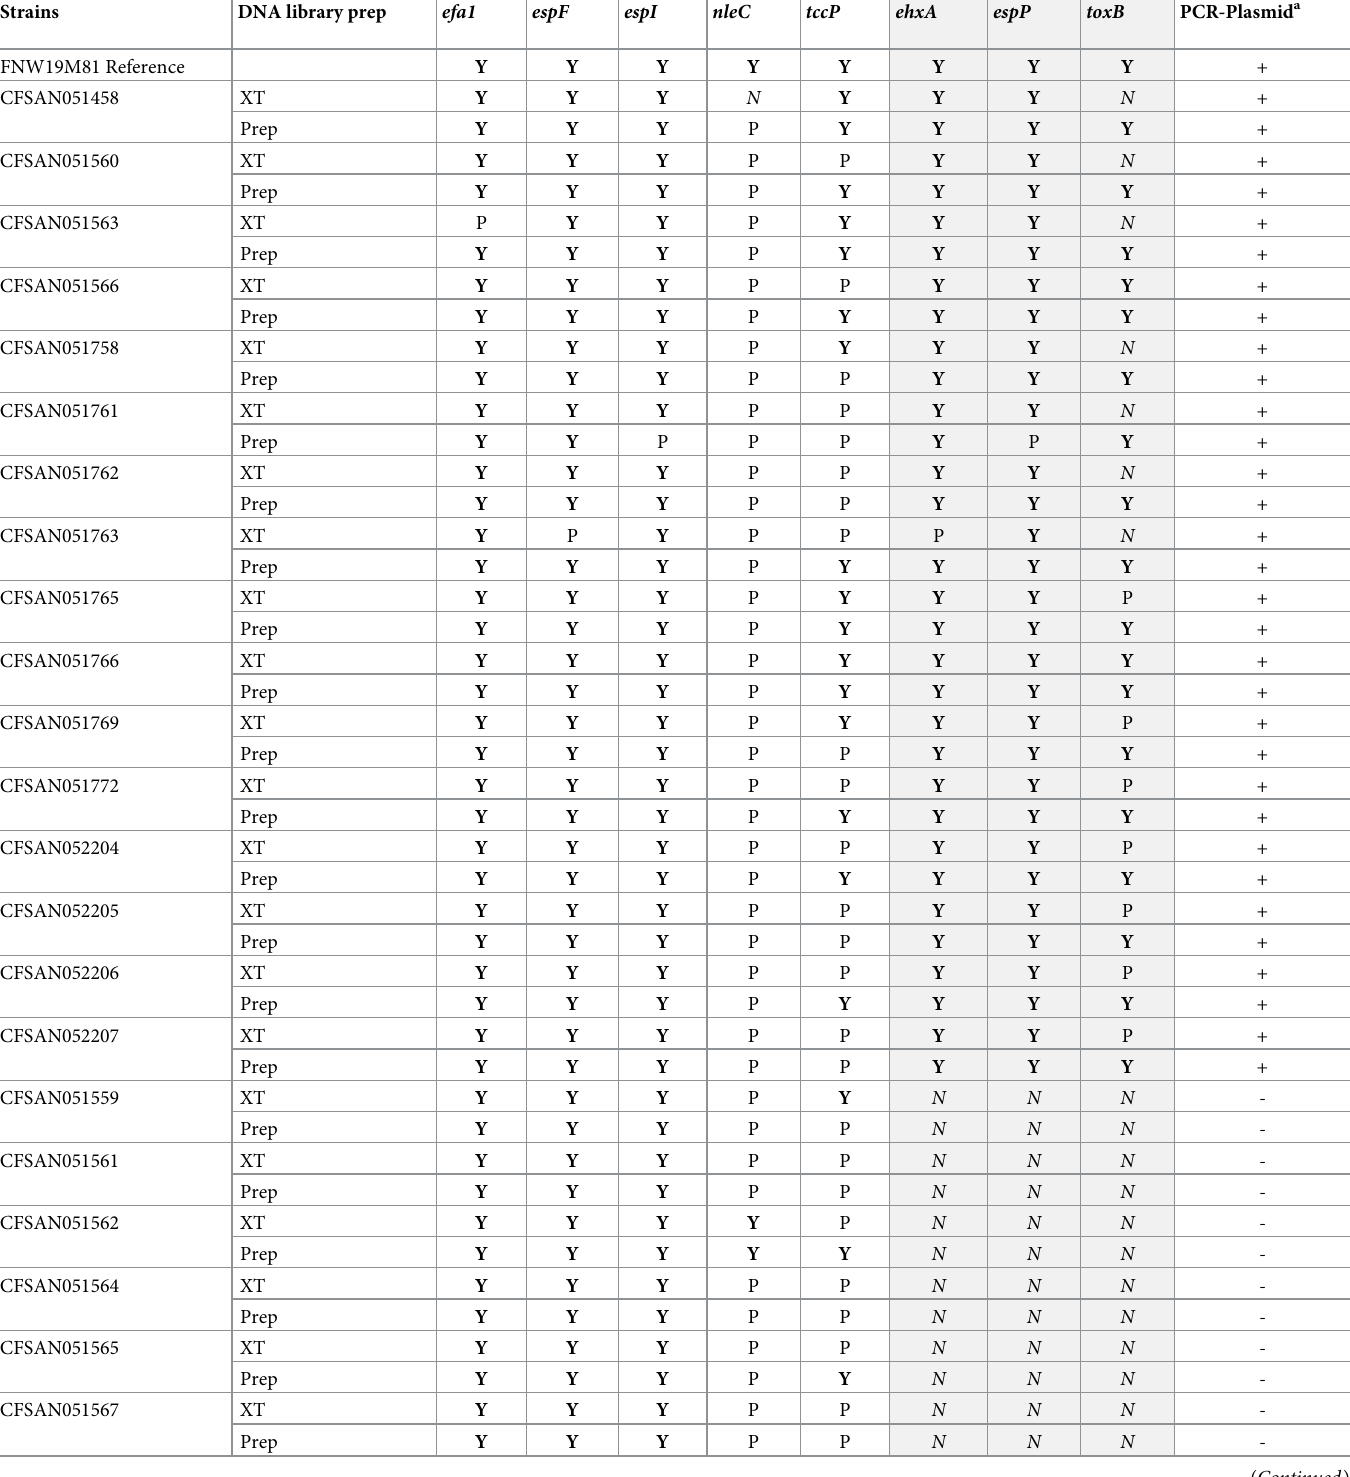
Table 3. AMRFinder Plus Results for the 31 STEC strains used in this study by DNA library preparation kit. Strains DNA library prep